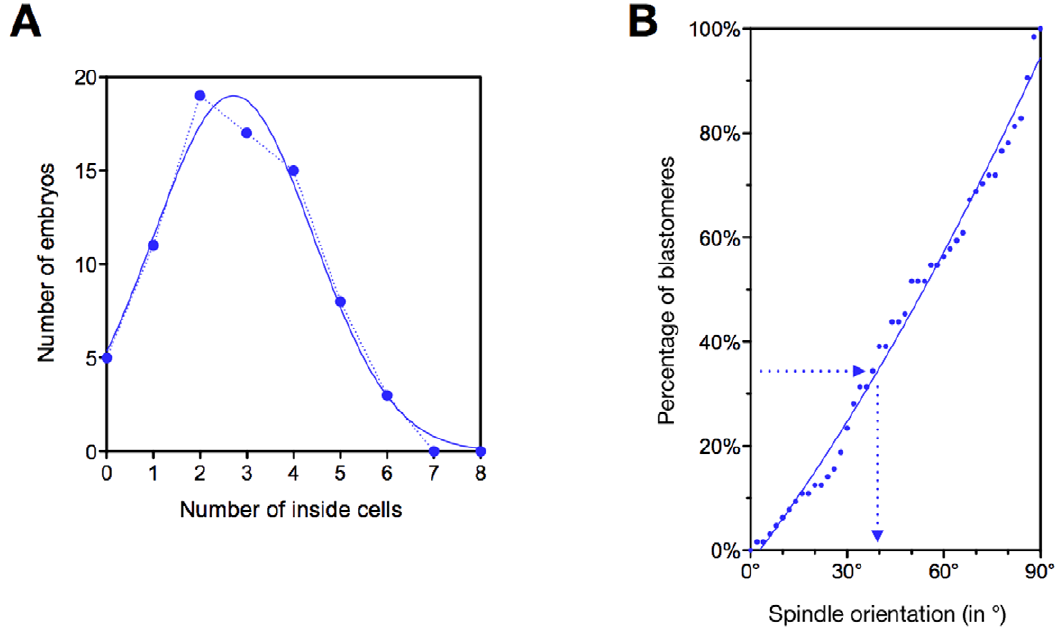
Figure 6. Spindle orientation and asymmetric divisions. A: The number of inside cells was measured in a population of 78 fixed 16-cell stage embryos. The dotted line corresponds to the experimental values and the plain line to the best fit. The mean number of inside cells was 2.8, corresponding to 35% of asymmetric divisions. B: Cumulative distribution of the a angle in living blastomeres (n=64). Blastomeres were sorted according to the value of the a angle. Each point on the graph corresponds to an increment of 2 u . The X axis corresponds to the a angle. The Y axis corresponds to the percentage of the population with an a angle smaller or equal to a given value. The best fit line was plotted using the least square method. 35% of asymmetric divisions correspond to a threshold angle of about 40 u (arrows).